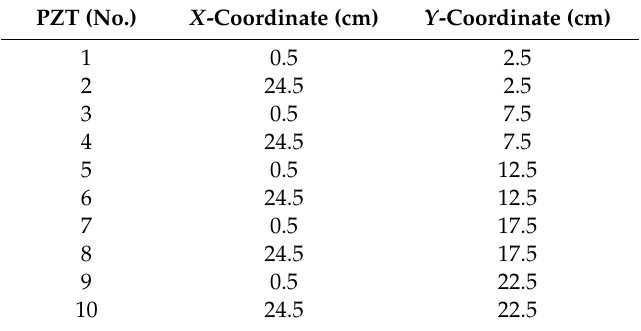
Figure 2. Schematic representation of the assigned piezoelectric transducer (PZT) network on the sample ACCS. Table 1. Coordinates (x,y) of the PZTs on the ACCS surface.